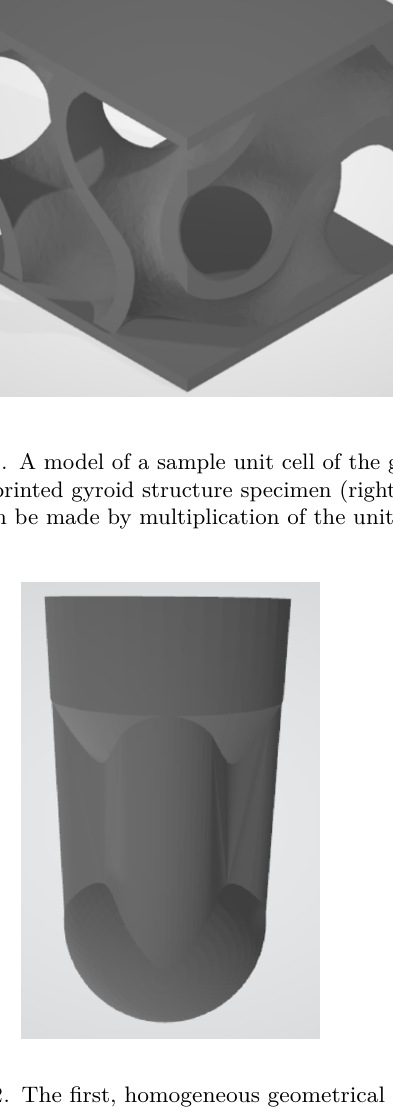
Figure 2. The first, homogeneous geometrical solu- tion of the dental implant used for numerical simula- tions. Implant was previously patented in the Czech Republic [7]. Image shows the intraosseous part.